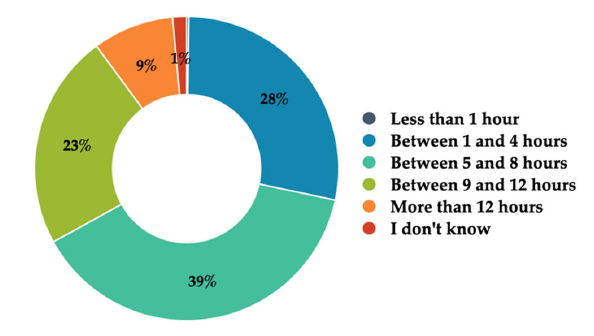
Figure 1. Average hours per day spent on the Internet. Of the 407 young adults surveyed, 42% admit to being permanently connected, as shown in Figure 2. The smartphone is the preferred device through which respondents access the Internet (74.7%), followed by the laptop (15.7%), the desktop at home (8.6%), the tablet (0.7%, corresponding to three respondents), and the desktop at the educational institution (0.2%, corresponding to one respondent).